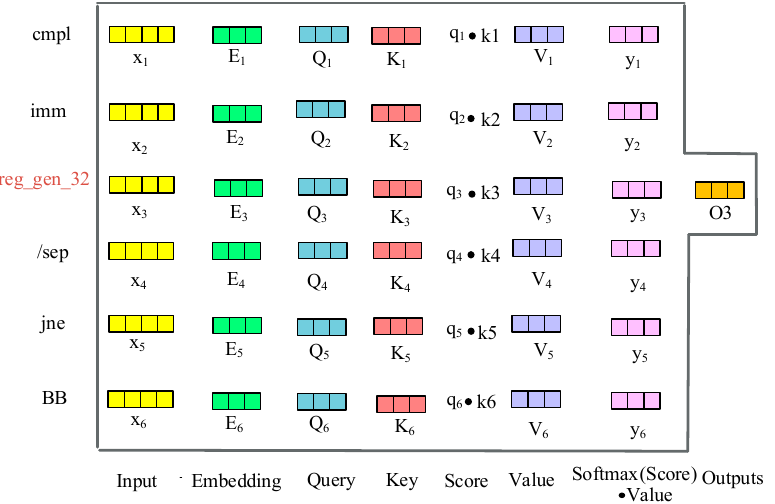
Figure 6. Calculation of the self-attention of token “reg_gen_32” based on the context token.